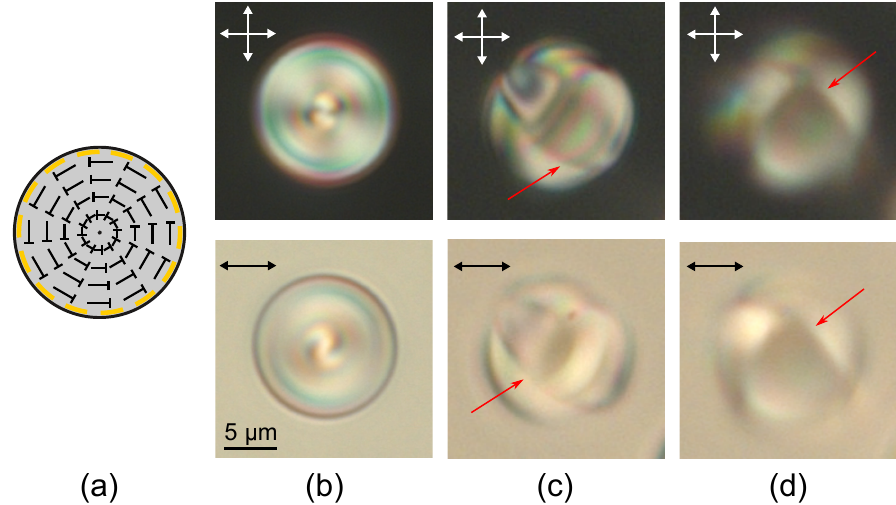
Figure 3. The cholesteric droplets at N 0 = 2.9. Scheme of the director orientation in the central cross section of droplet with the plane of circular defect parallel to film plane ( a ). POM photos of CLC droplets with the circular defect plane oriented parallel ( b ), at approximately 50 ◦ angle ( c ), ( d ) to the film plane taken in the crossed polarisers (top row) and without analyser (bottom row). The microscope is focused on the upper ( c ) and lower ( d ) part of the circular defect. Single arrows indicate a position of the linear defect.